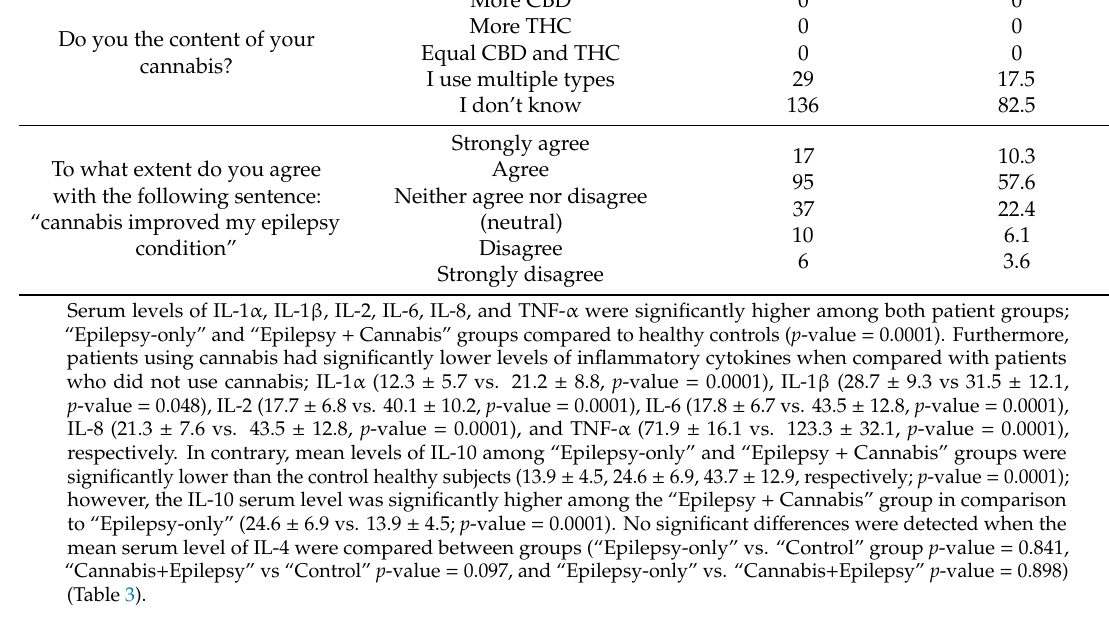
Table 3. Comparisons of the serum inflammatory cytokine levels among the Control group, the Epilepsy-only group and the Epilepsy + Cannabis